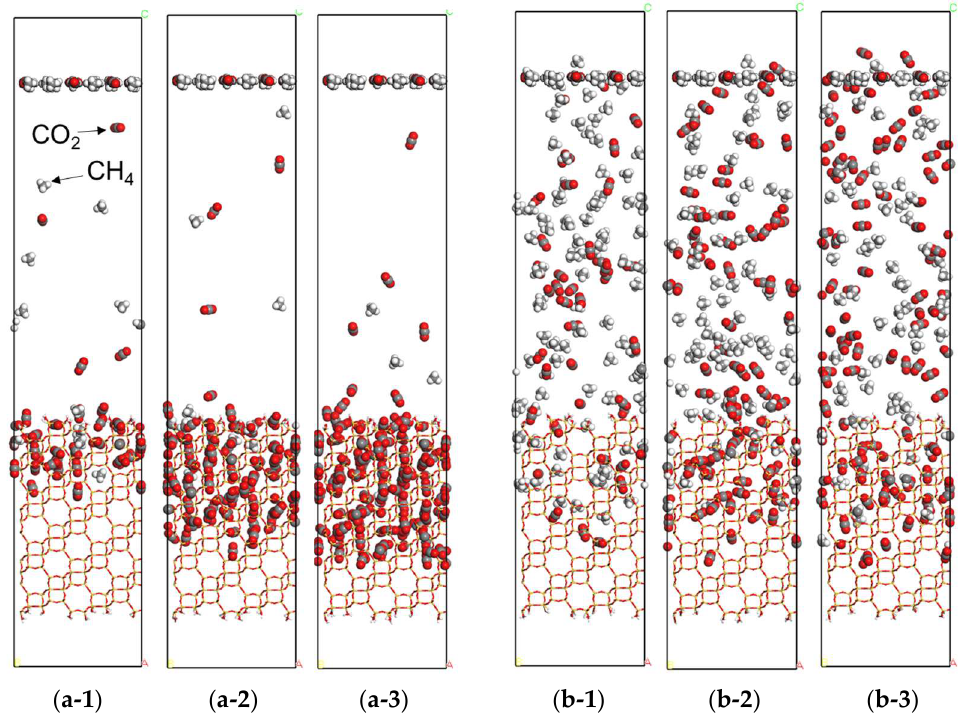
Figure 2. The snapshots of the unit cell at different simulated times were obtained from CO 2 /CH 4 mixture gas permeation simulations using NEMD. CO 2 and CH 4 molecules by the CPK model represented the carbon atoms in gray, oxygen atoms in red, and hydrogen atoms in white, whereas the CHA zeolite was represented by the stick model. ( a ) 0.5 MPa, ( b ) 8.0 MPa, ( 1 ) 5 ns, ( 2 ) 10 ns, ( 3 ) 15 ns.